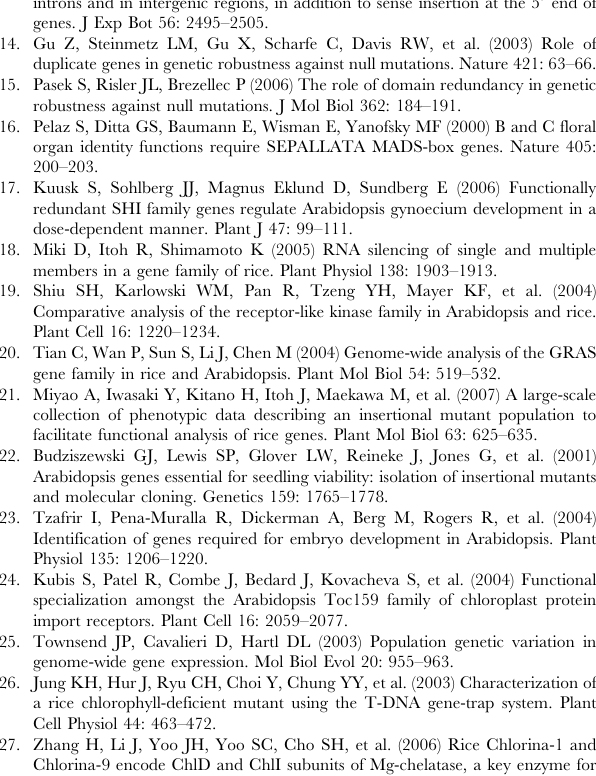
Table S5 Primers used for Genotyping 20 Light-Inducible Primary Candidate Genes.